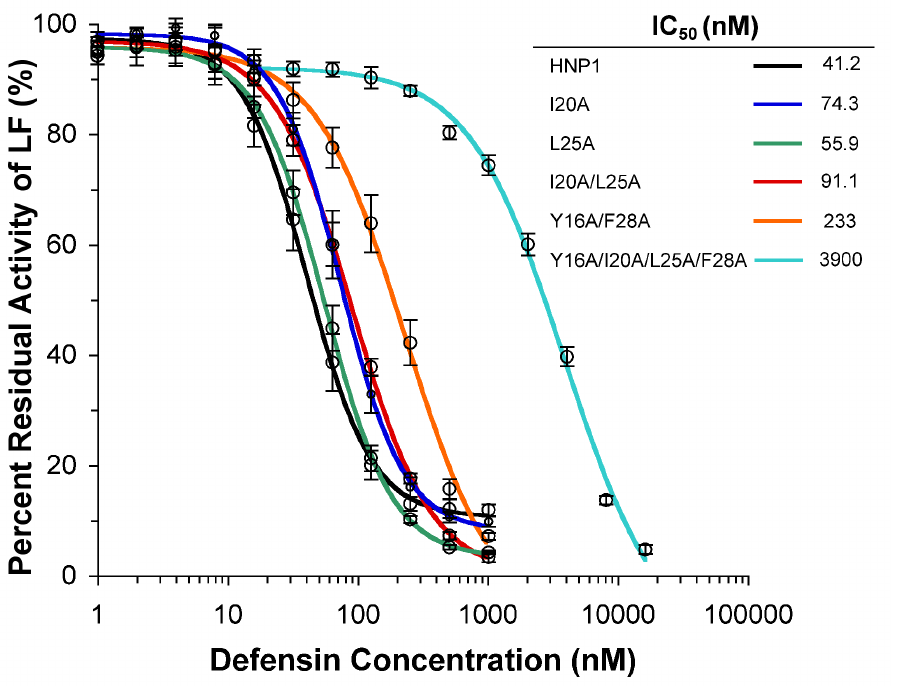
Figure 9. Inhibition of LF activity by different concentrations of HNP1 and mutant analogs. Each inhibition curve is the mean of three independent enzyme kinetic measurements except Y16AF28A-HNP1, which is the mean of duplicate measurements.